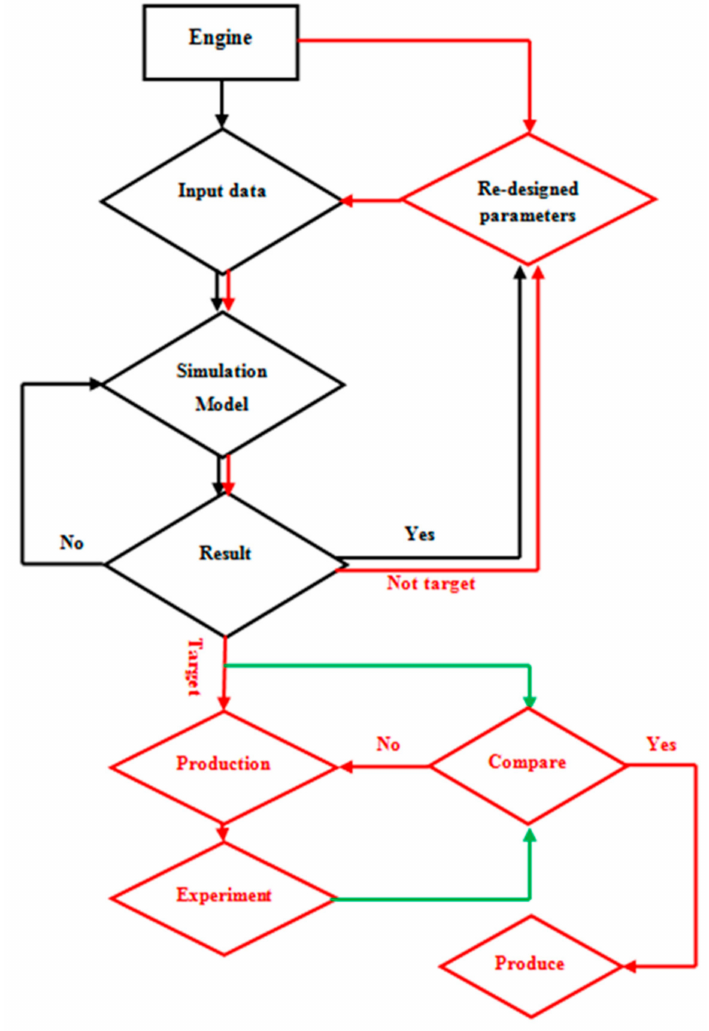
Figure 4. Flowchart of the